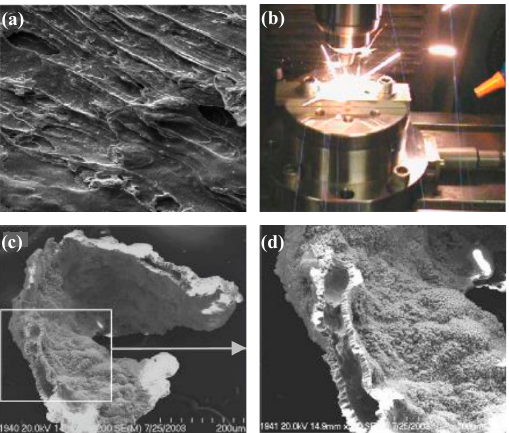
Figure 18. ( a ) Viscous flow on the surface of the chips produced after Fe − Si − B was cut in two dimensions [100]. ( b ) Pyro luminescence phenomenon during cutting of Zr-based BMG. ( c , d ) SEM image of the Zr − based BMG after the pyro luminescence, where severe oxidation and crystallization of the BMG can be observed [114].